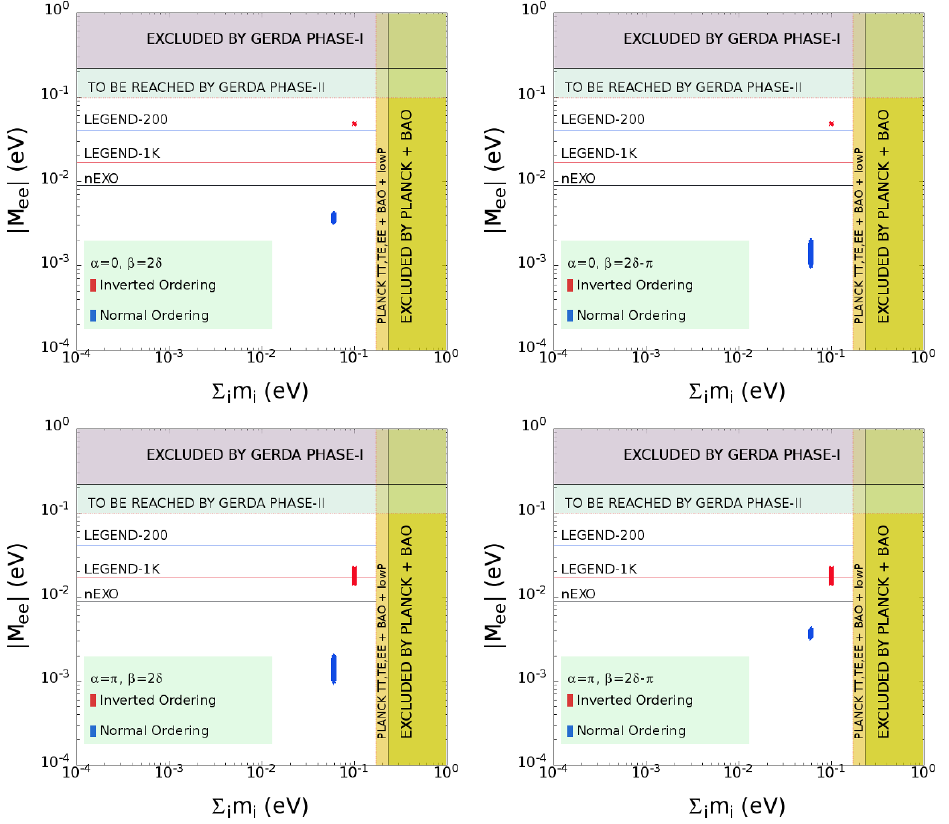
Figure 2 . Plots of j M ee j vs. m min for both types of mass ordering with four possible choices of the Majorana phases (cid:11) and (cid:12)